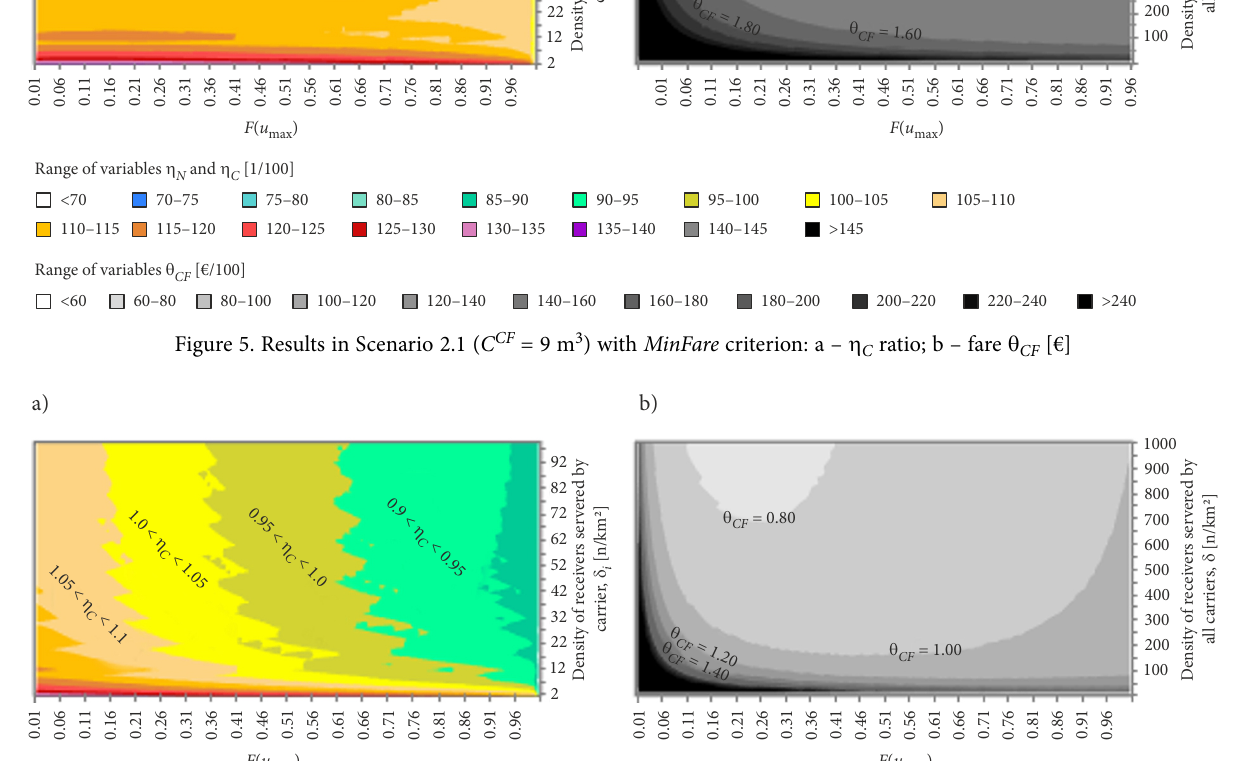
Figure 6. Results in Scenario 2.2 ( C CF = 2.16 m 3 ) with MinFare criterion: a – h C ratio; b – fare q CF [€]